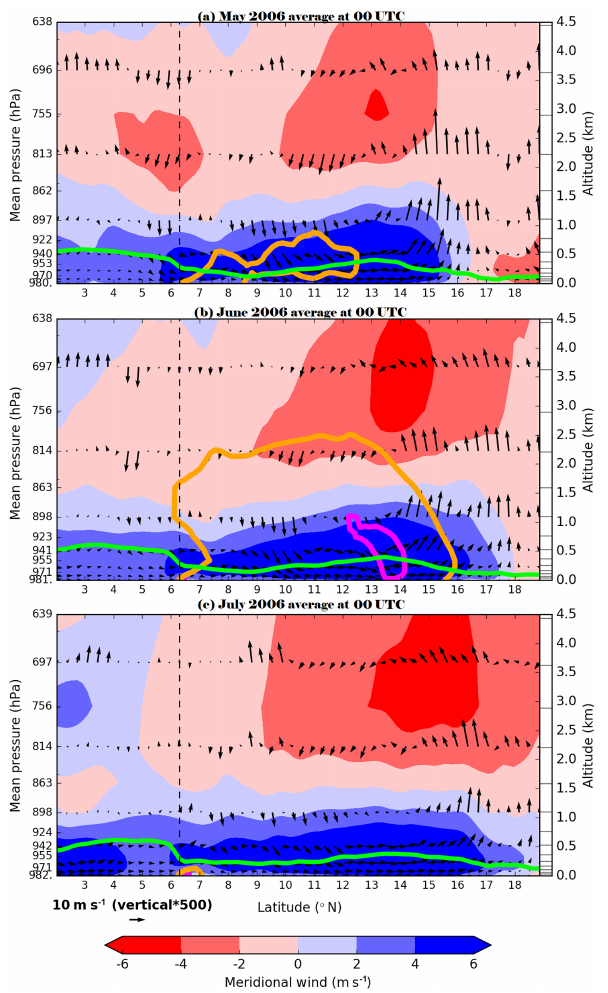
Figure 7. Vertical cross section of the meridional wind (shading in ms − 1 ) mean over (a) May, (b) June and (c) July, at 00:00UTC along a meridional transect from 2 to 19 ◦ N and averaged from 2 to 3 ◦ E including Cotonou (Benin) and Niamey (Niger). Orange and violet shading represents anthropogenic PM 2 . 5 concentrations of = 4.0µgm − 3 and = 5.0µgm − 3 . Vectors represent the wind field in the plan of the transect (with an aspect ratio of 500 between the meridional and the vertical components). The green line is the PBL height (m). The gray vertical dash line is the latitude of the coast.